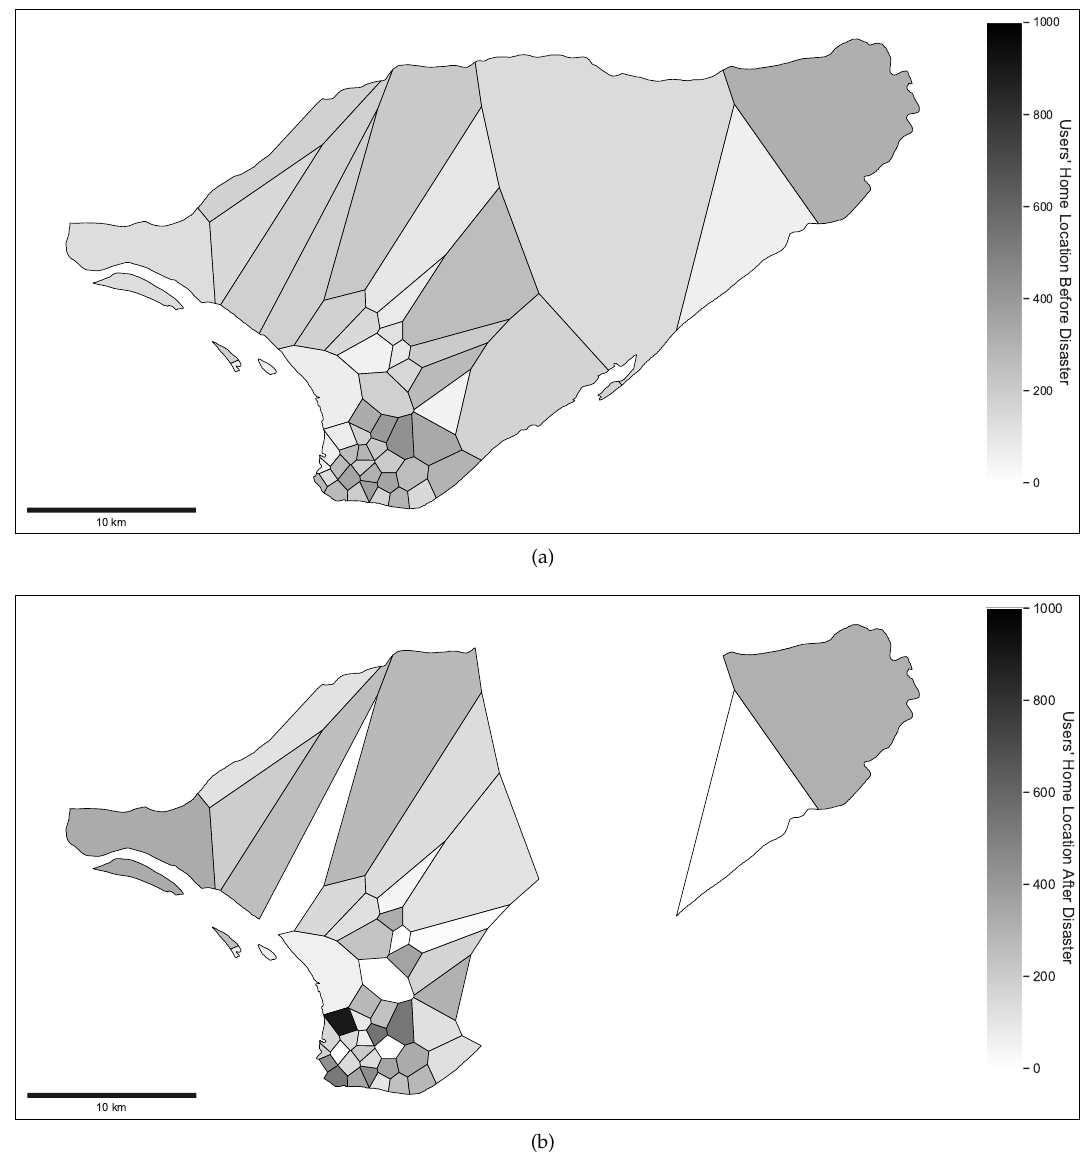
Figure 8. ( a ) Aggregated mobile phone users before the disaster and ( b ) aggregated mobile phone users after the